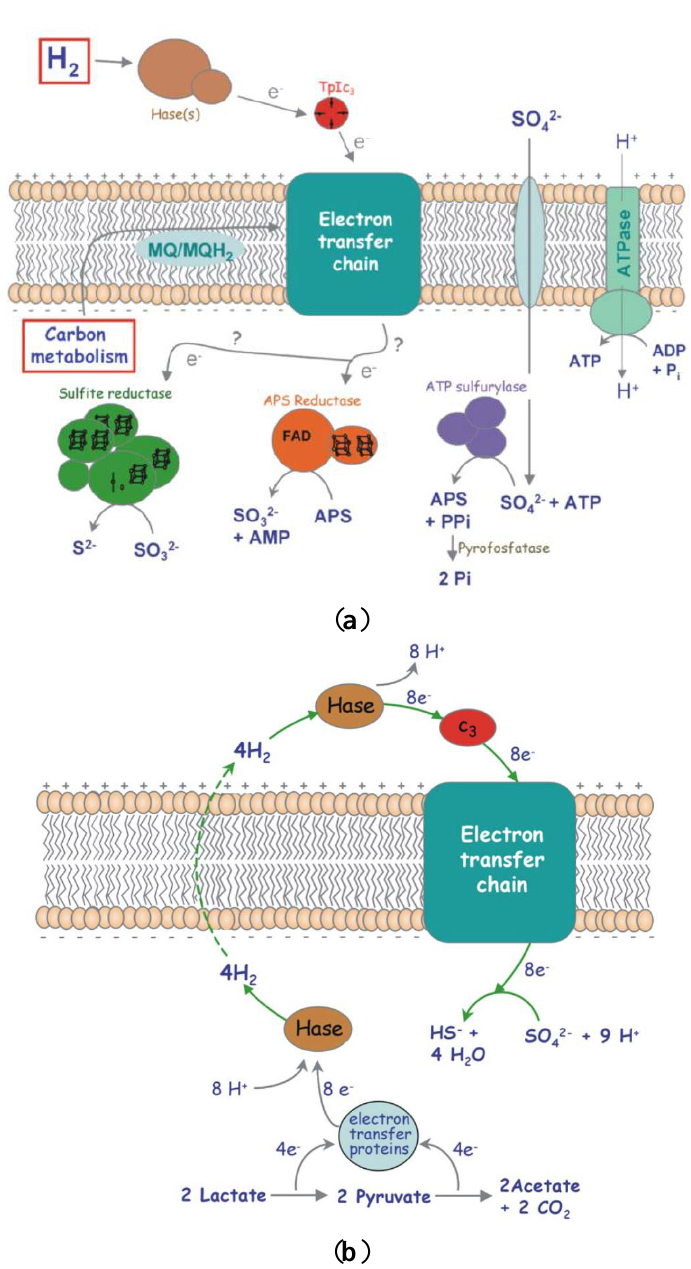
Figure 10. Network of redox proteins playing a role in the metabolism of Desulfovibrio vulgaris : ( a ) Schematic representation of the respiratory electron transfer chain in Desulfovibrio, with H 2 or organic compounds as energy source and sulphate as terminal electron acceptor; ( b ) The hydrogen cycling mechanism to explain energy conservation in Desulfovibrio, while growing in lactate/sulphate